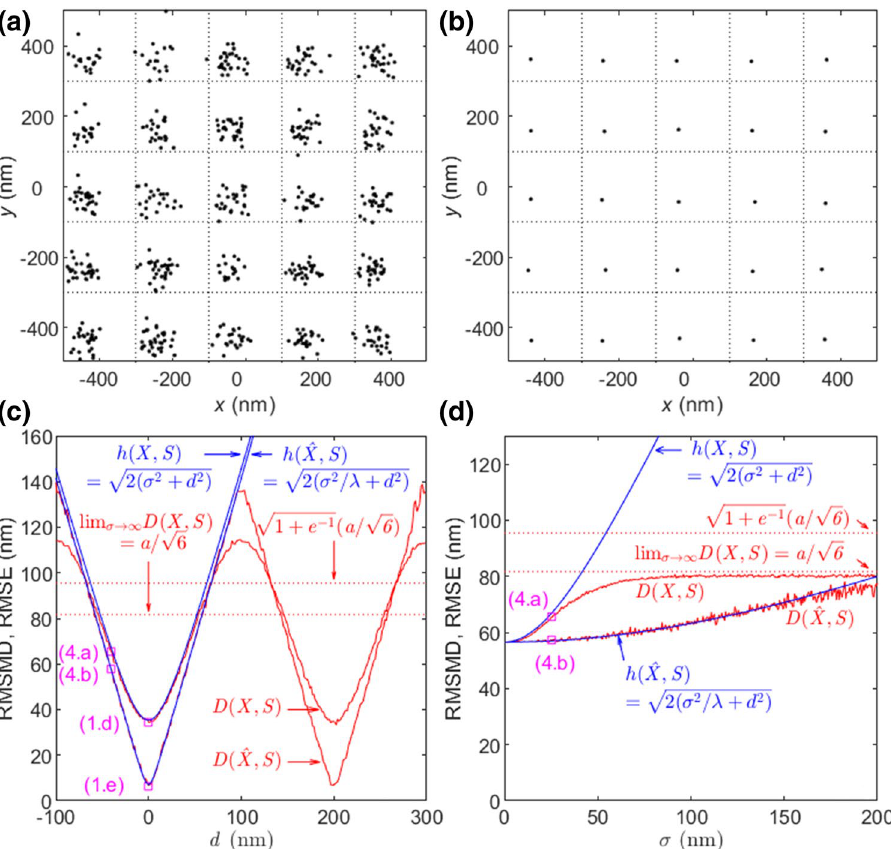
25 . ( a ) X with σ 25 nm and d 40 nm. = = = − 25 nm. The =